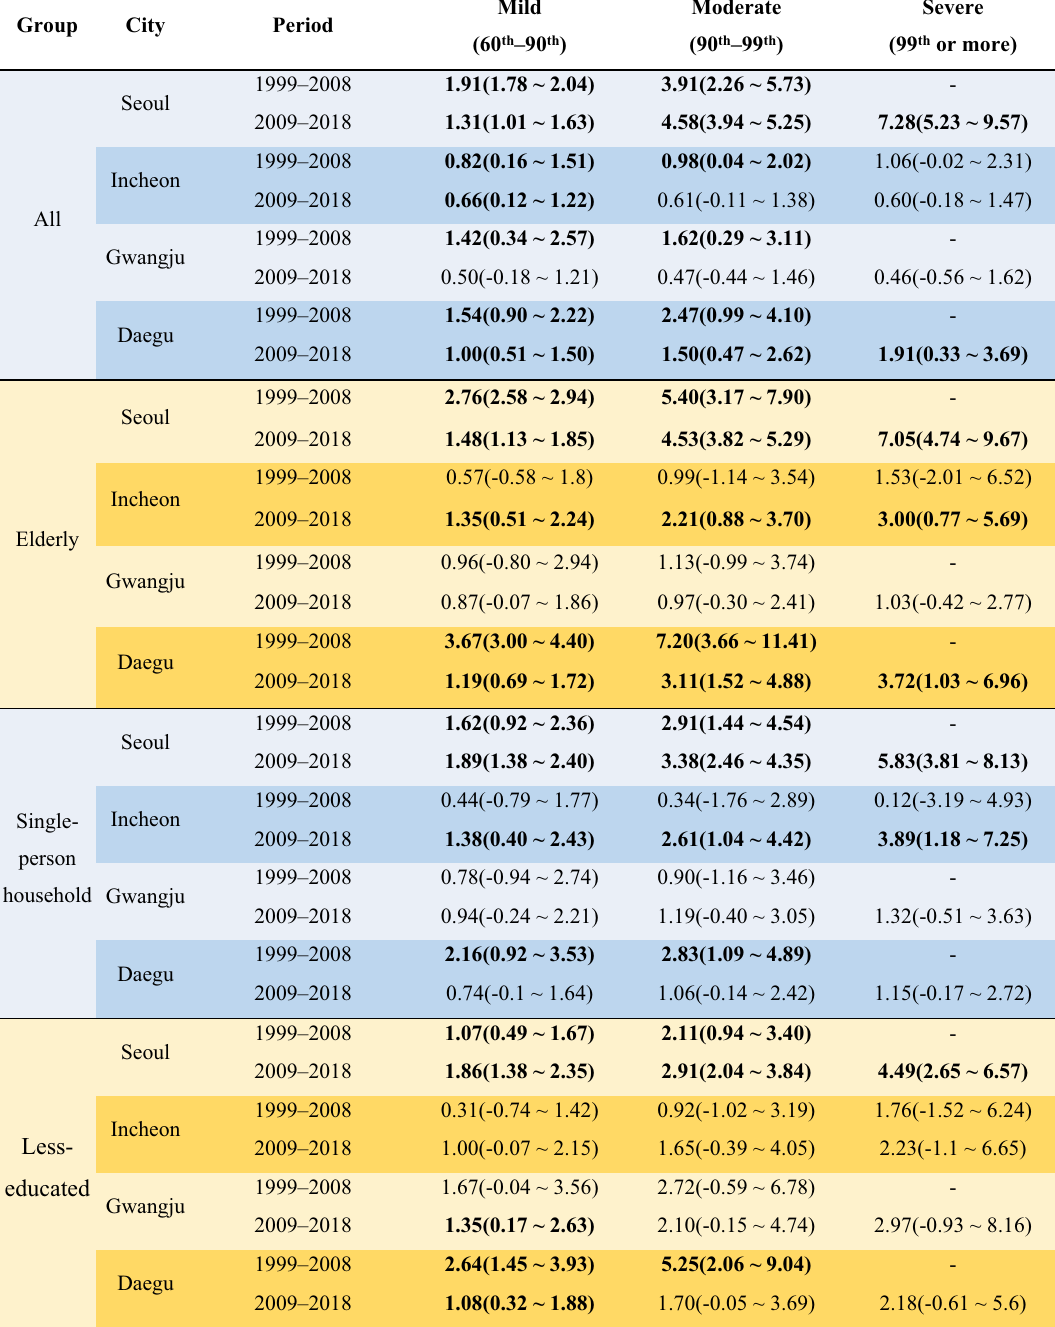
Table 2. Percent change in relative risk for mortality at 95% confidence interval for three Tmax ranges. ‘–’ indicates the absence of the 99th percentile temperatures in the past (1999–2008). Bold values mean that RR was increased statistically